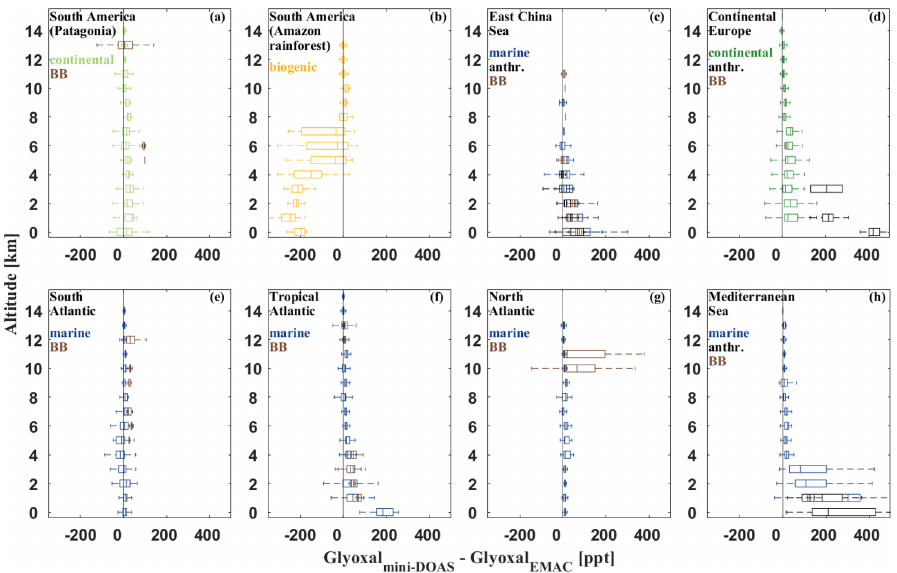
Figure 11. Difference in measured airborne and EMAC simulated glyoxal for the different regions. Continental measurements are shown in green, measurements over the rainforest in yellow, and marine observations in blue. For the comparison, only positive valued measurements are considered due to the missing randomness of the model simulations (see the text). Since no EMAC simulations are available for the measurements over the Amazon Rainforest in 2014 and over the Mediterranean and Near East in 2015, simulations performed for the year 2017 are used instead (panel b and a minor part of the data in panel h ). The data are plotted in 1km altitude bins for the 25th to 75th percentiles (whiskered boxes) with respective medians and with in-range minima and maxima. Profiles for identified emission events (see Fig. 4 and Sect. 4.1) are calculated separately (biomass burning in brown and anthropogenic emissions in